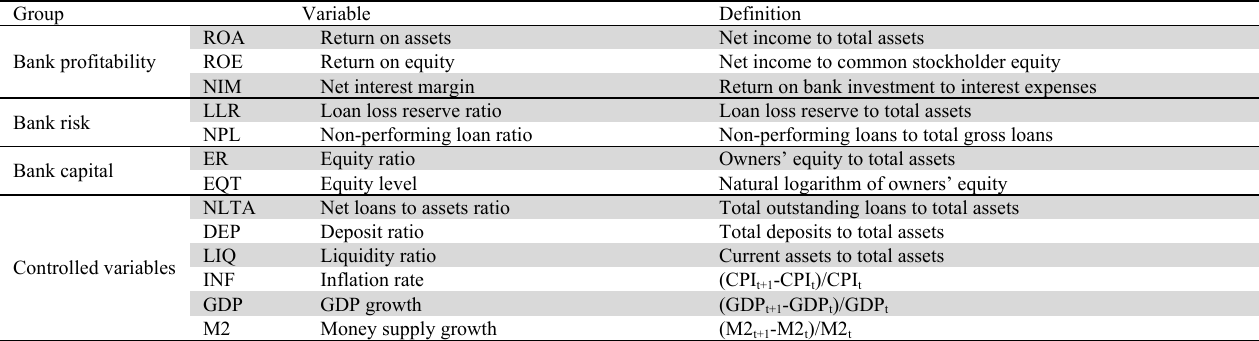
Variable definitions